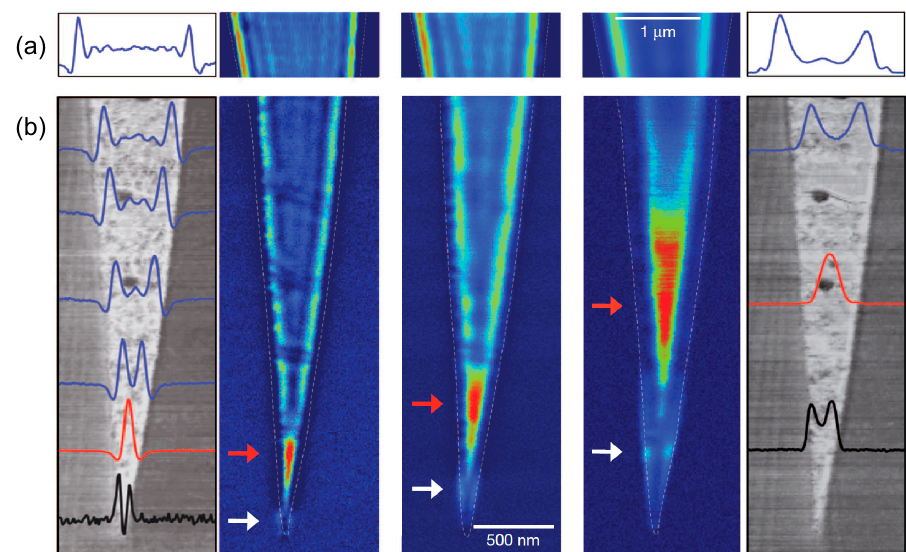
Figure 3. S-SNOM images of graphene plasmons. ( a ) 1 mm wide graphene nano ribbons on an SiC substrate. The black and white images show AFM morphology, while the colored images were taken with 9200 nm (left), 9681 nm (middle) and 10,152 nm (right) light wavelengths. The line plots on the panels at the far left and right edges represent the near-field images for λ o = 9200 nm and λ o = 10,152 nm; ( b ) Tapered graphene ribbons on the same SiC substrate imaged with SNOM, where the arrows indicate localized resonant modes. Reproduced with permission from [38], Copyright Nature, 2012.